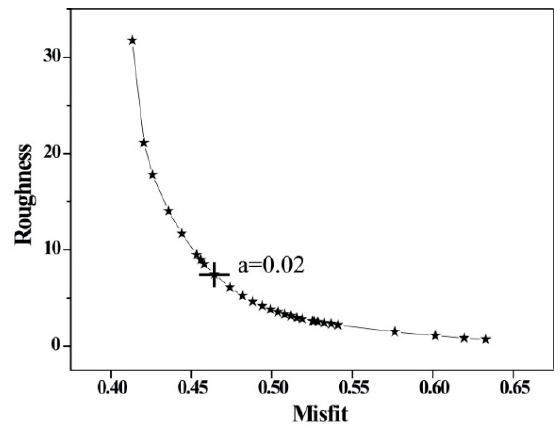
Figure 4. Trade-off curve between roughness and relative fitting residuals. The cross represents the location of the smooth factor used in modeling.